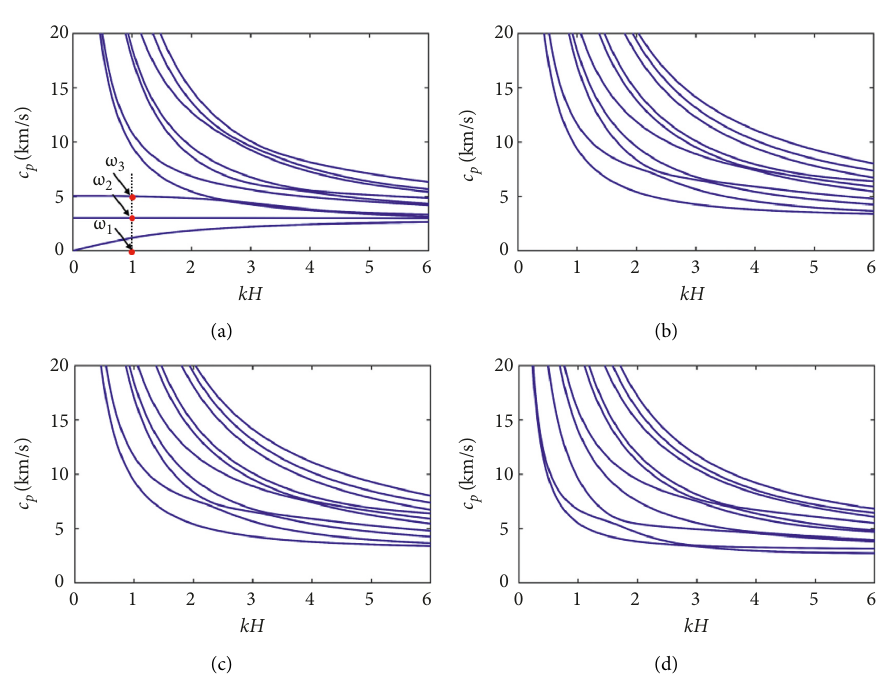
Figure 5: Dispersion curves of guided waves in the four-layered plate with the boundaries of (a) FOO-FOO, (b) COO-COO, (c) CSS-FOO, and (d)